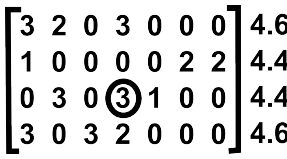
Fig. 1. A scheduling matrix considering 4 nurses and 7 days. Last column shows the penalties associated to each nurse